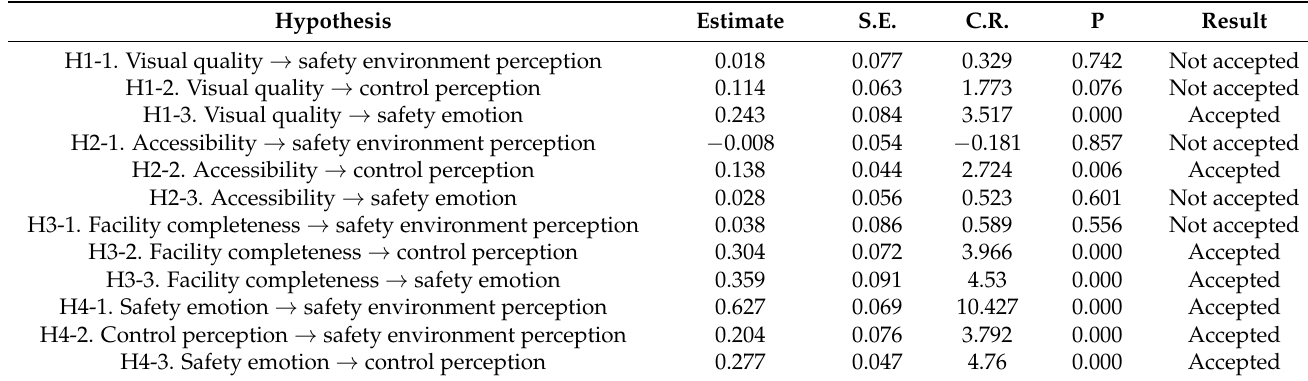
Table 6. Summary of hypotheses’